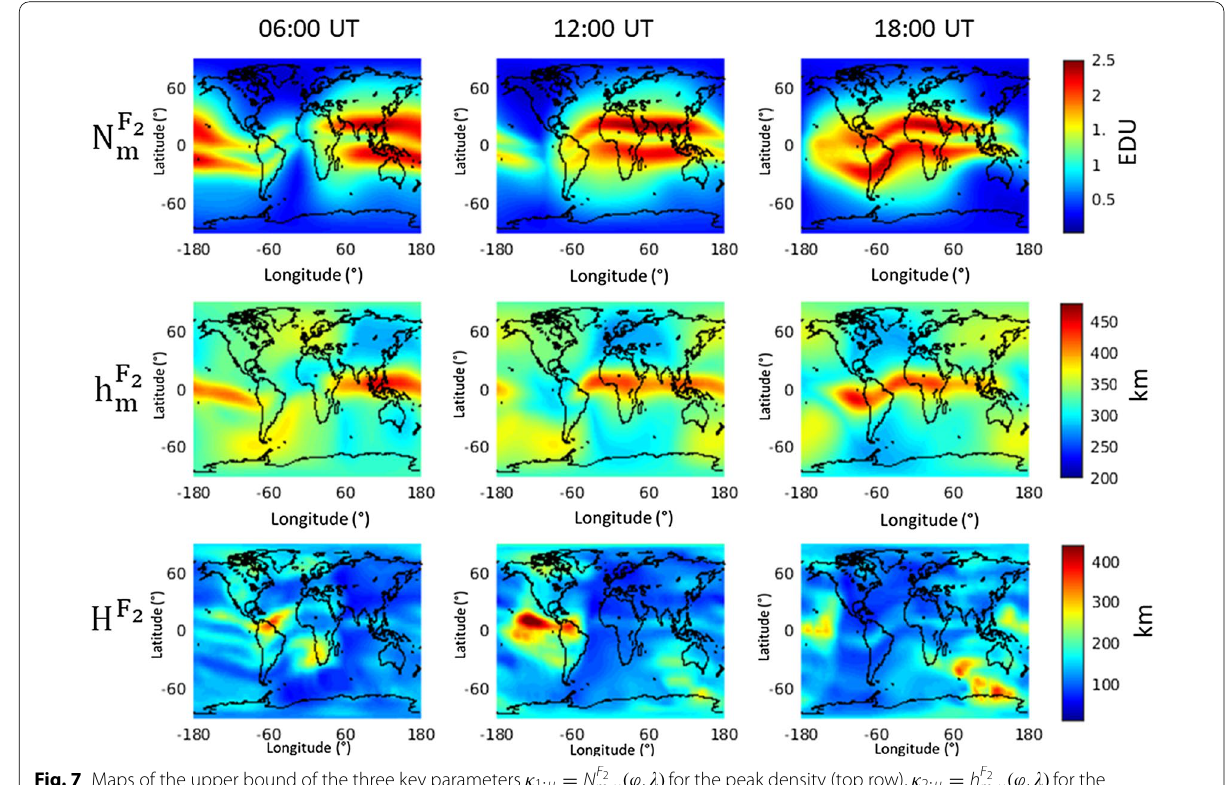
Fig. 7 Maps of the upper bound of the three key parameters κ 1 ; u = N F 2 m ; u (ϕ , (cid:31) ) for the peak density (top row), κ 2 ; u = h F 2 m ; u (ϕ , (cid:31) ) for the corresponding peak height (middle) and the scale height κ 3 ; u = H F 2 u (ϕ , (cid:31) ) (bottom) at three different time epochs on March 12,